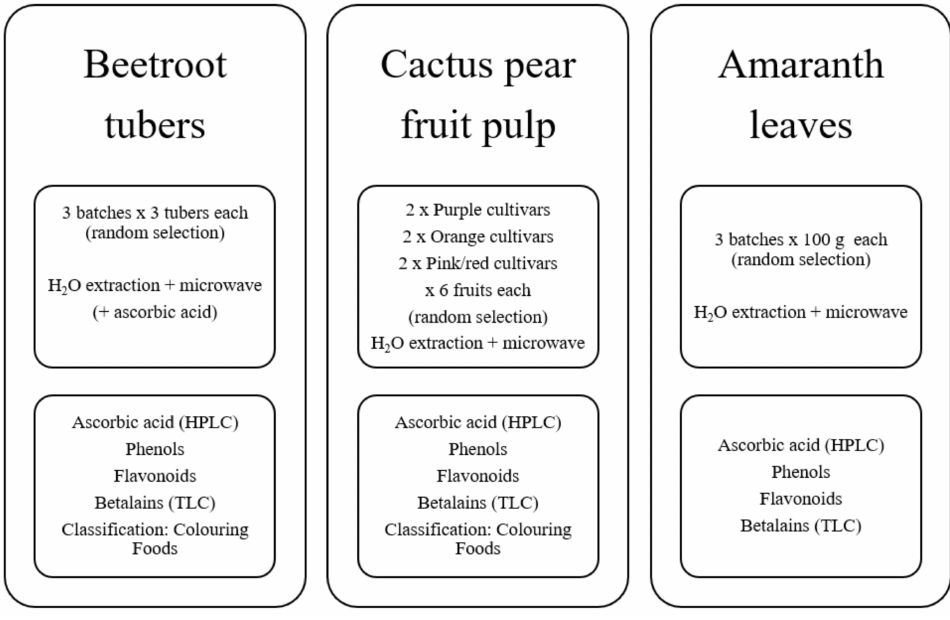
Figure 5. Experimental